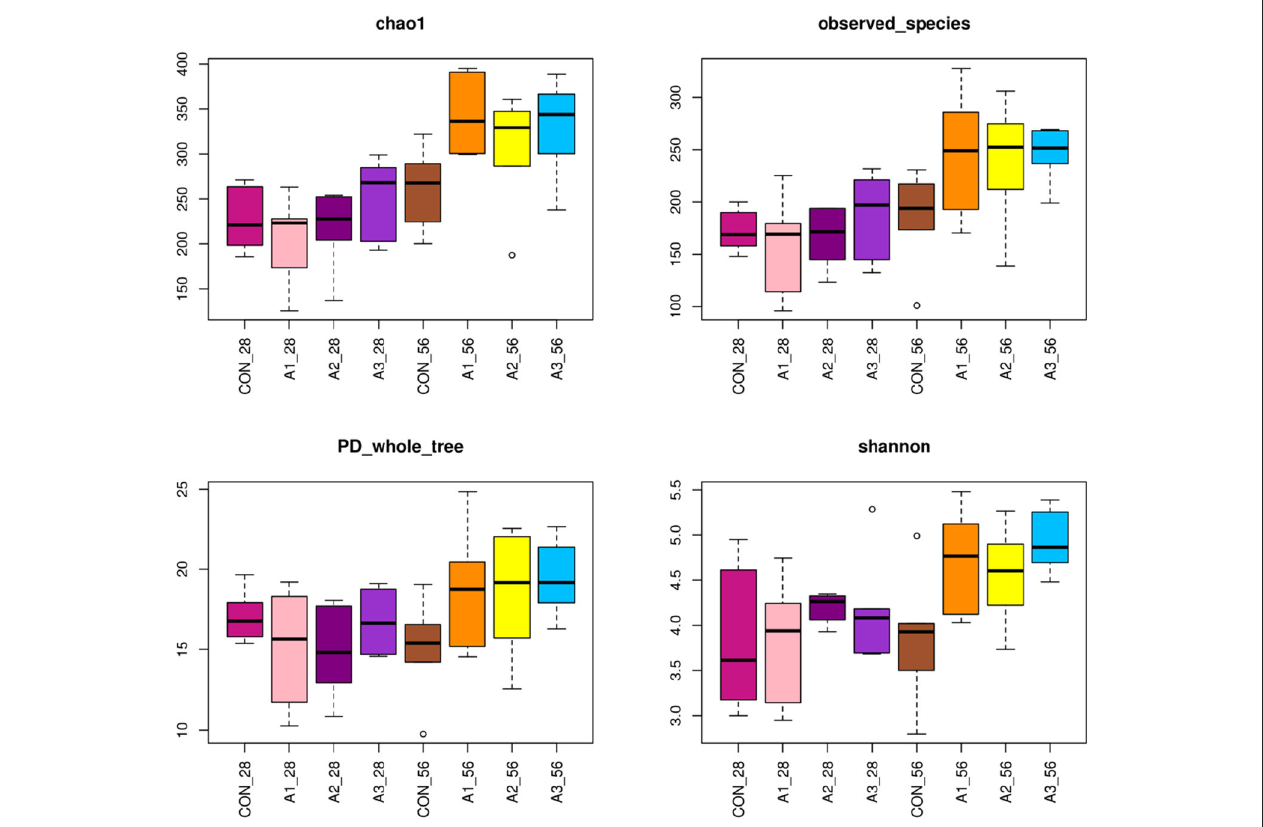
FIGURE 3 | Richness estimates and diversity indices for bacteria with four groups. The top and bottom boundaries of each box represent the 75th and 25th quartile values, respectively. The horizontal lines inside each box represent the median values. CON, the dosage of B4 is 0mg / day; A1, the dosage of B4 is 15mg / day; A2, the dosage of B4 is 30mg / day; A3, the dosage of B4 is 45mg /